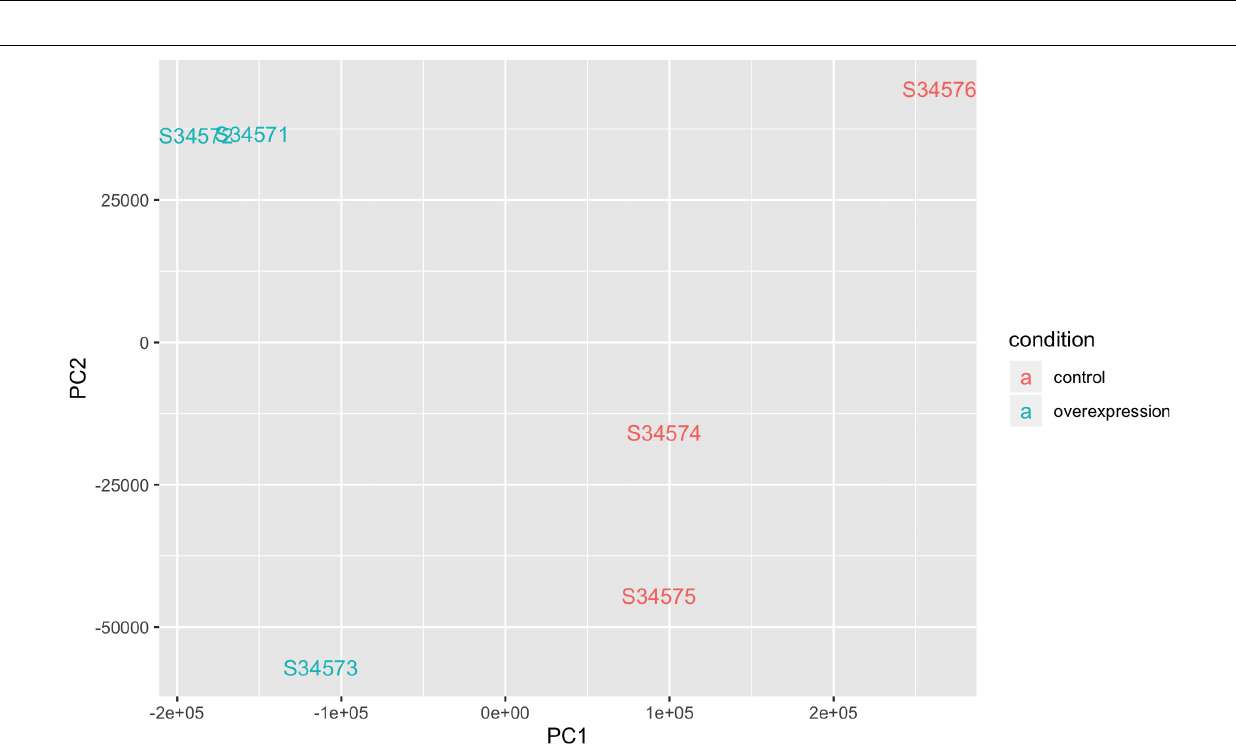
Frontiers in Genetics |